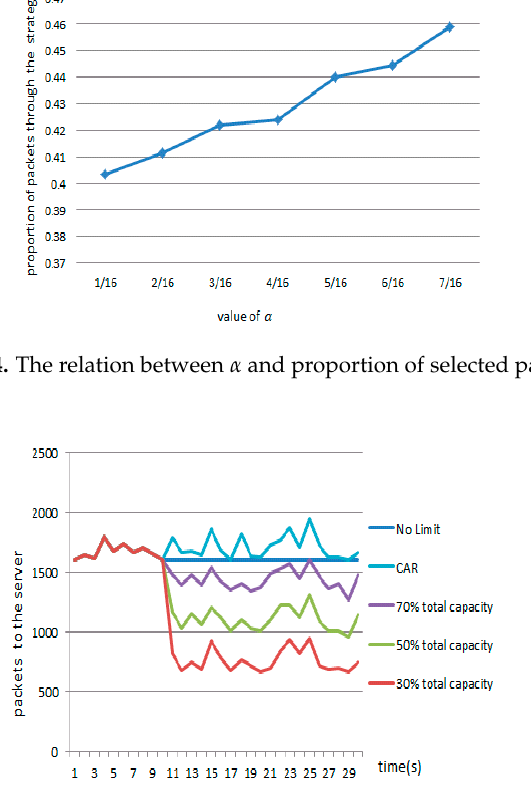
Table 4. Packets and time statistics for the experiment in different  .